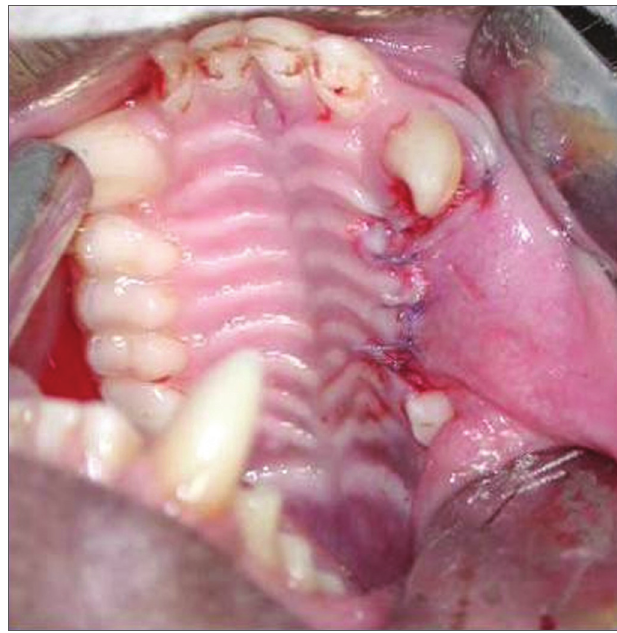
Figure 1. Exodontia of three upper